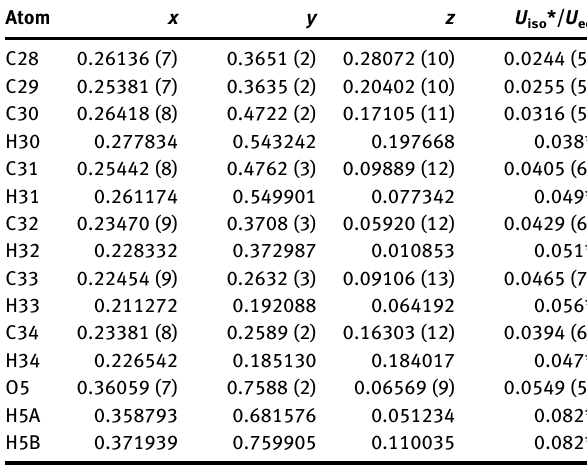
The title compound was synthesized similar to that reported in the literature [5]. In 15 mL distilled H